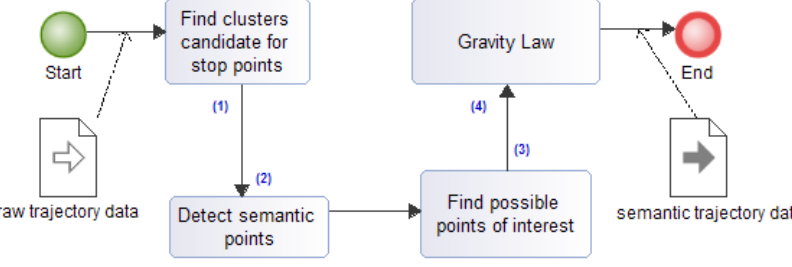
Figure 7. Process of semantic enrichment performed by the